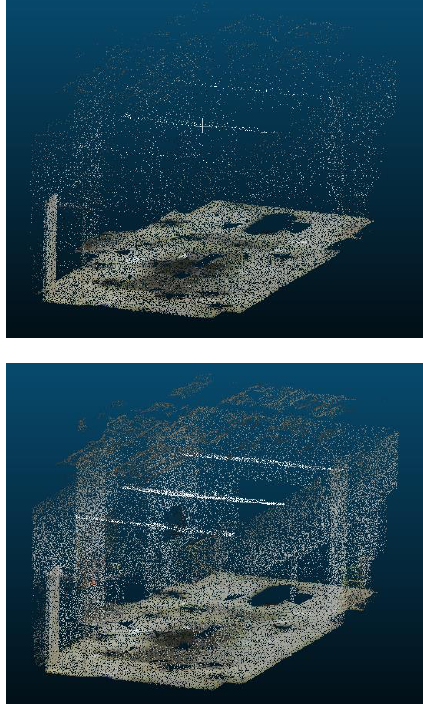
Figure 4. Visualization of a conference room using the indoor cLoD model. The scenes contain first 50 000, 100 000 points respectively sorted by the cLoD